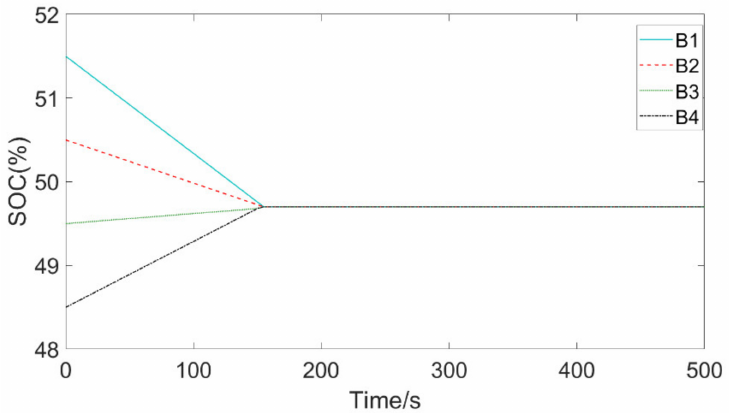
Figure 5. Simulation of cascaded Buck-Boost balance circuit based on